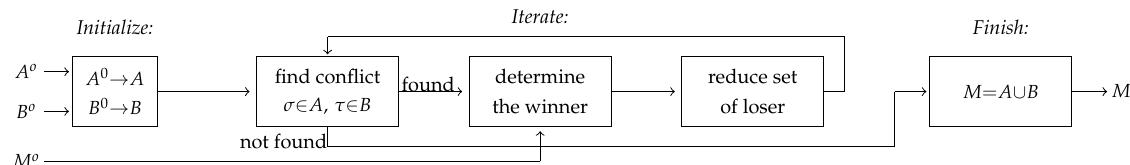
Figure 7. Outline of Algorithm 2. The Initialize step sets A and B . The Iterate step is executed until no more conflicts are found. Conflicts are resolved using the hint from the additional input M o , then the command sets A and B are reduced. If no conflict remains, the merger M = A ∪ B is returned by the Finalize step. Algorithm 2 (Synchronization of disjunct sets) . Initialize: Set A o → A and B o → B